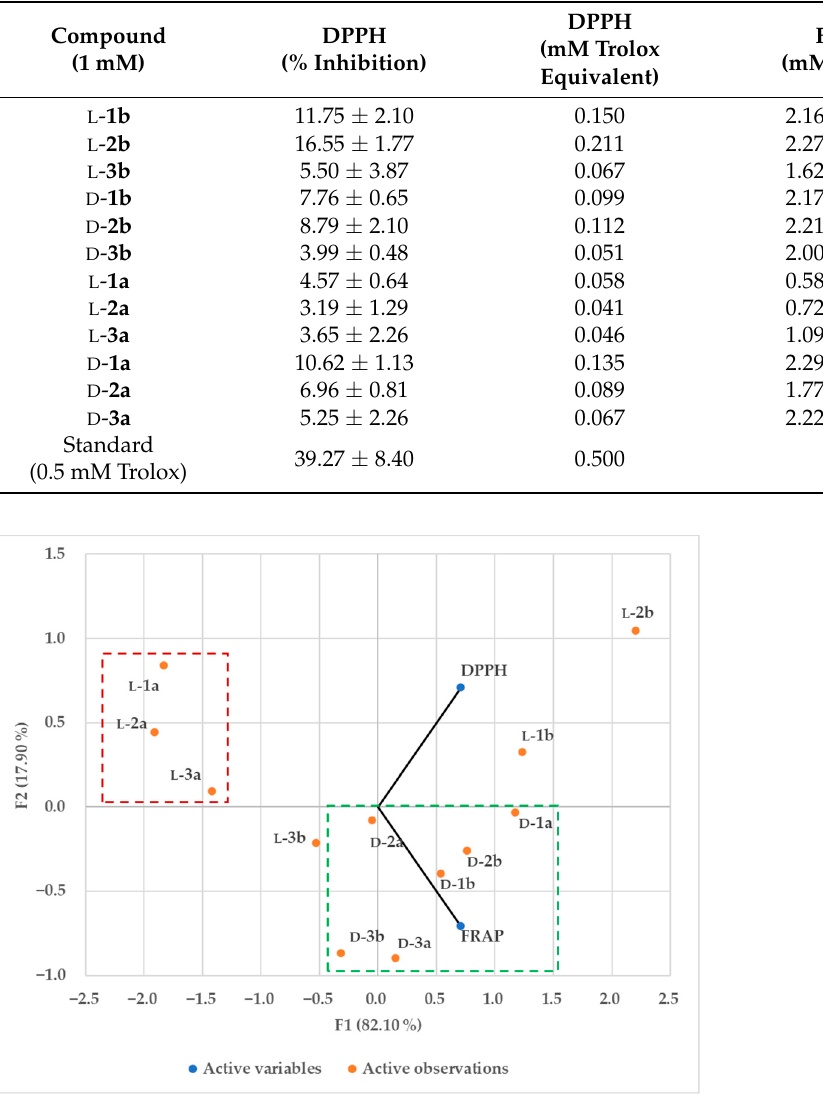
Figure 12. Principal component analysis (PCA) plot of different dipeptides based on their antioxi- dant activity; highlighted in green—dipeptides with D -amino acids and higher antioxidant activity; highlighted in red—dipeptides with L -amino acids and acetyl as the protecting group with the lowest antioxidant activity. Table 3. Antioxidative activity of ferrocene compounds evaluated using free 1,1-diphenyl-2-pic-